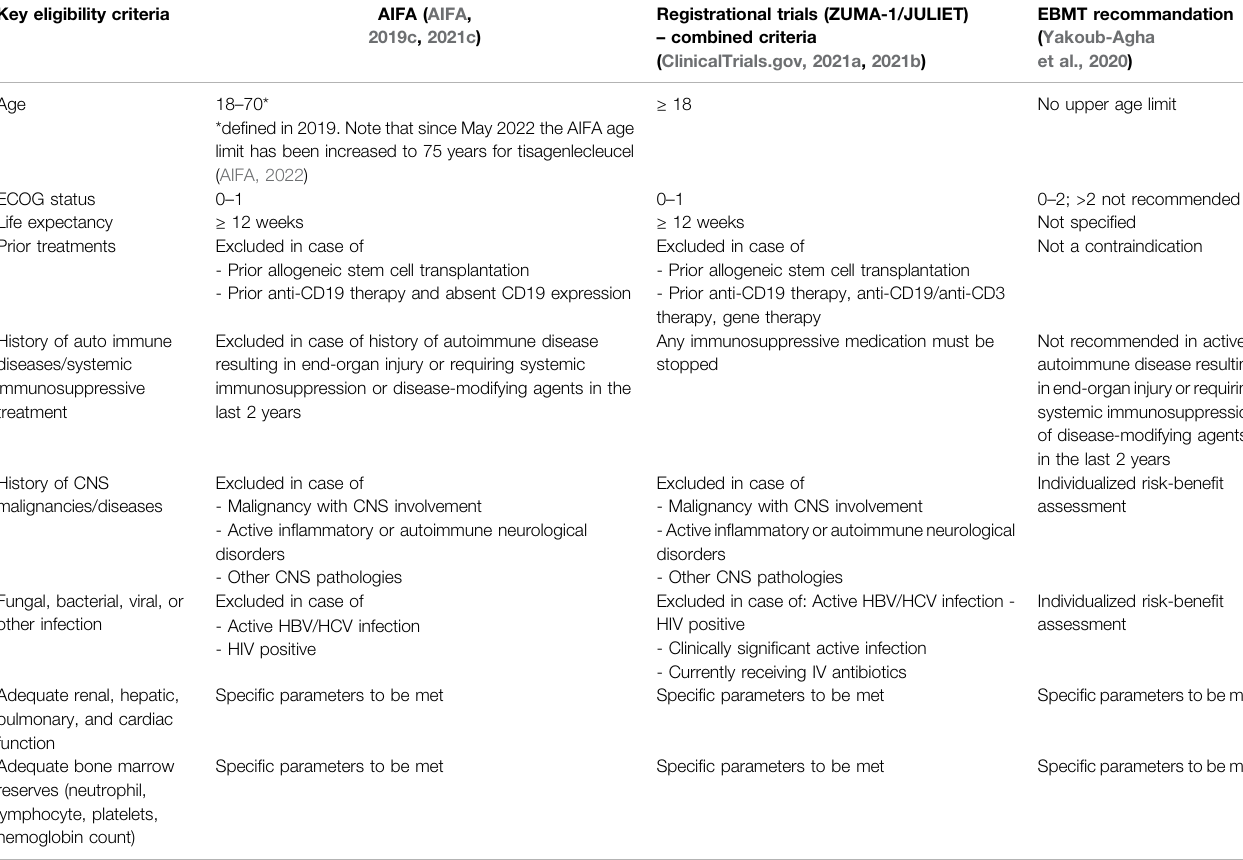
TABLE 2 | CAR T-cell therapy eligibility criteria for DLBCL